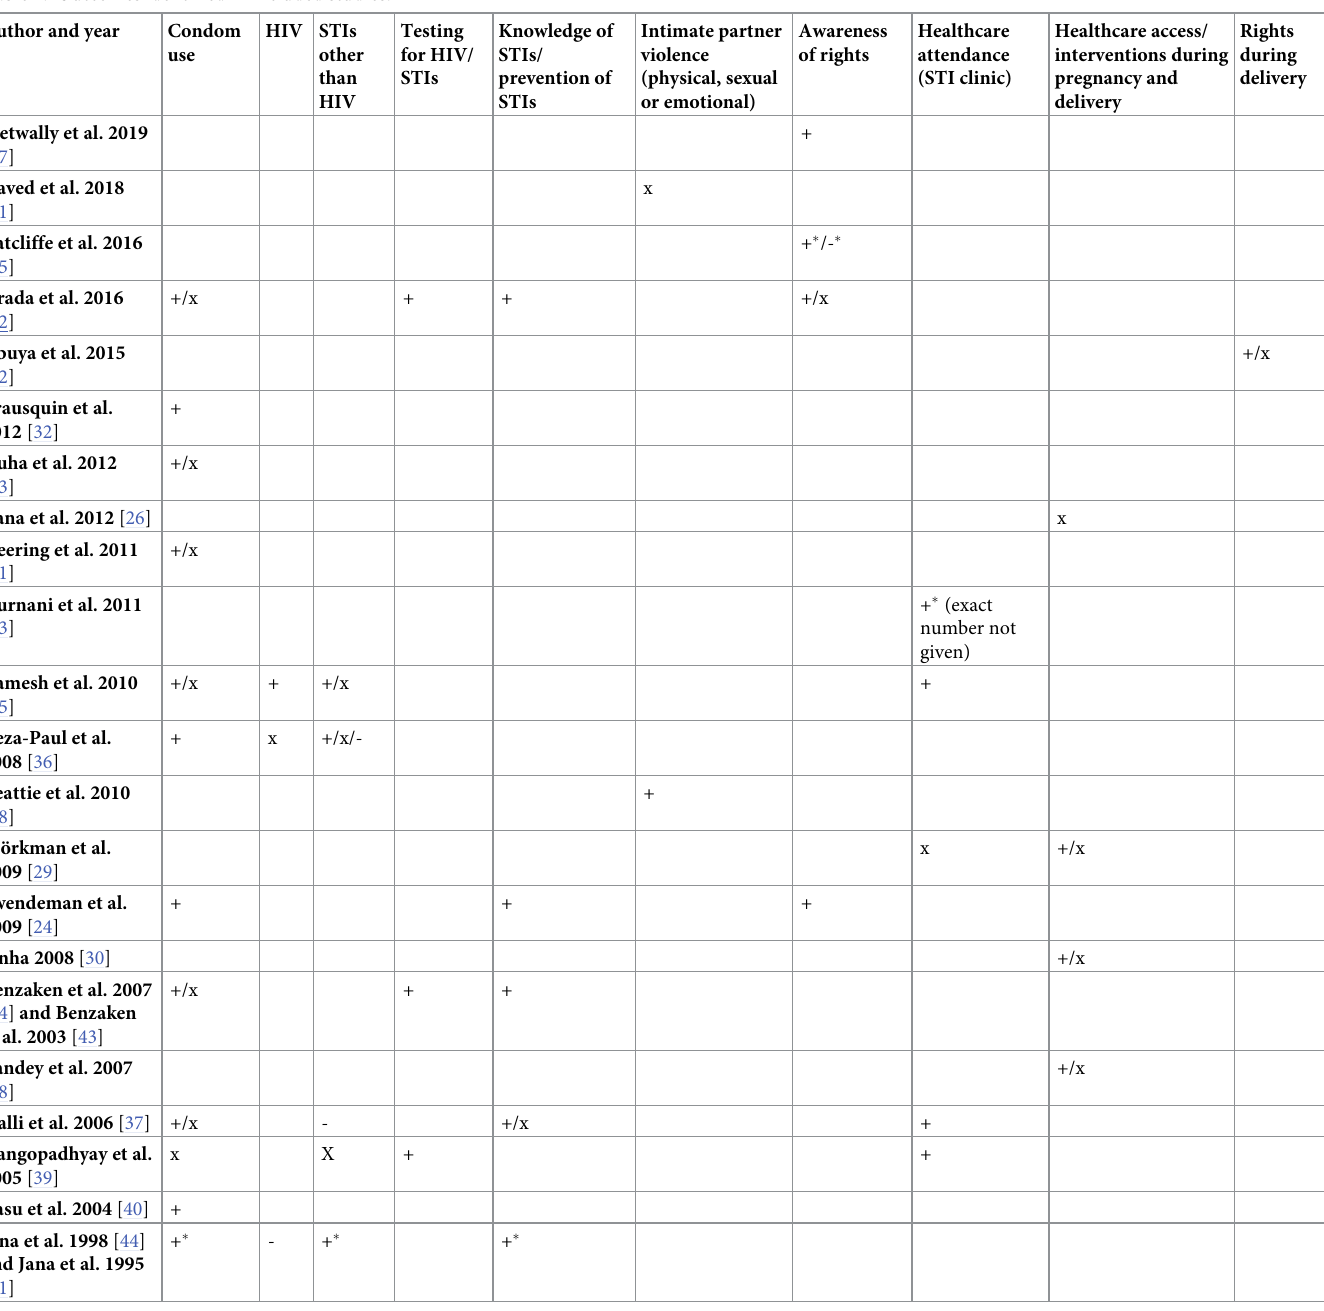
Table 2. Outcomes identified in included